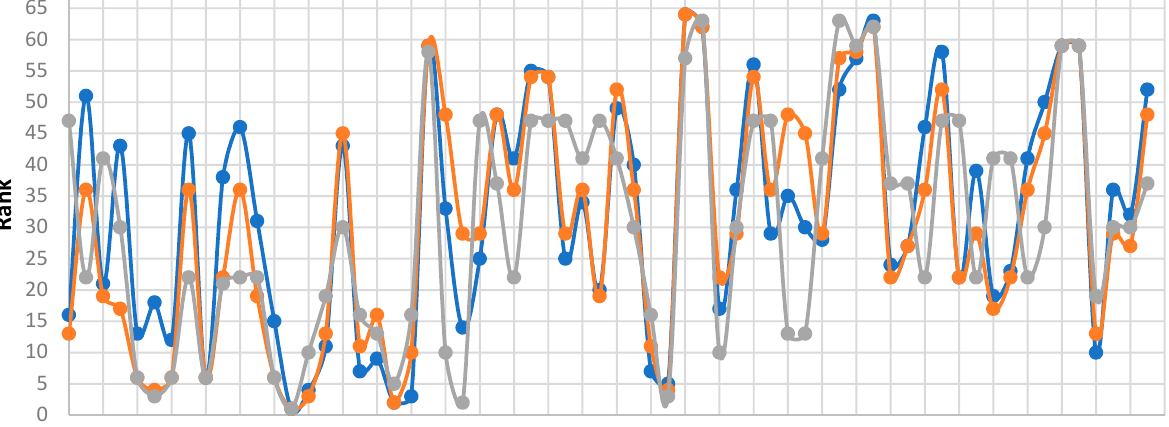
DCRS—Dempster Schafferis risk cost; DCRT—Dempster Schafferis risk of timeline; FLRC—fuzzy